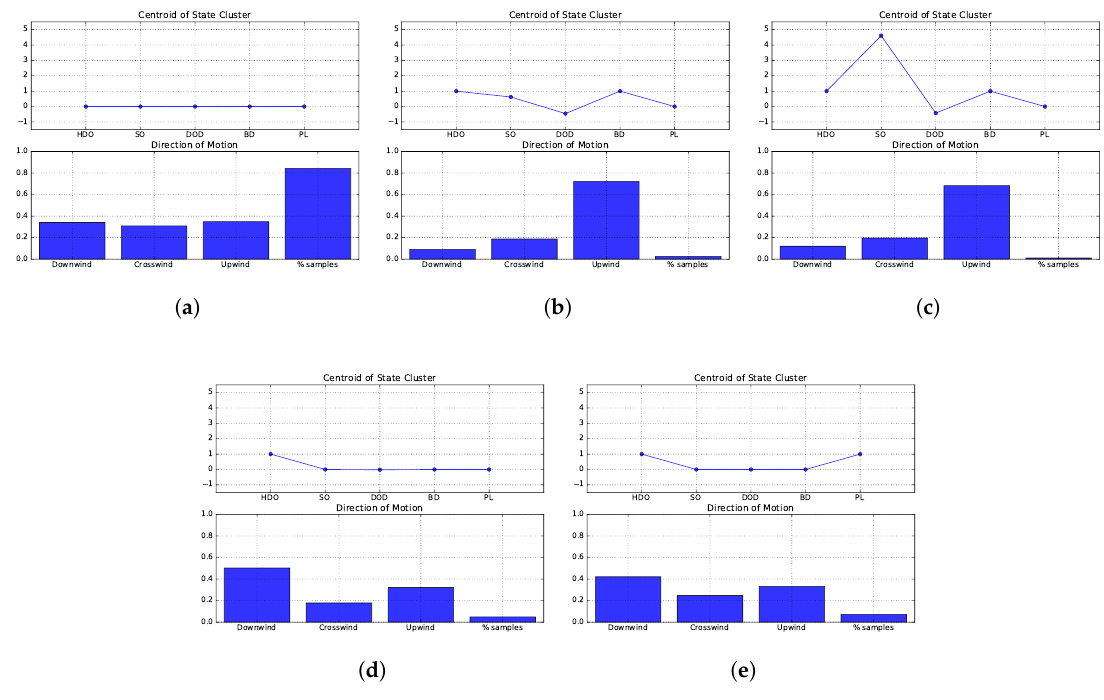
Figure 11. 5 state-action mappings for environment 2. The top of each sub-figure presents the centroid of the respective state cluster. The bottom of each sub-figure presents the histograms of relative frequency of the actions taken by all strategies in the respective state, characterized by the direction of motion. A fourth column is presented in these histograms, representing the relative amount of simulation steps that all strategies spent perceiving the respective state. ( a ) State 1: the robot has yet to detect odour; ( b ) State 2: the robot is detecting low concentrations of odour; ( c ) State 3: the robot is detecting high concentrations of odour; ( d ) State 4: the robot has recently lost the odour plume; ( e ) State 5: the robot has lost the plume for an extended time